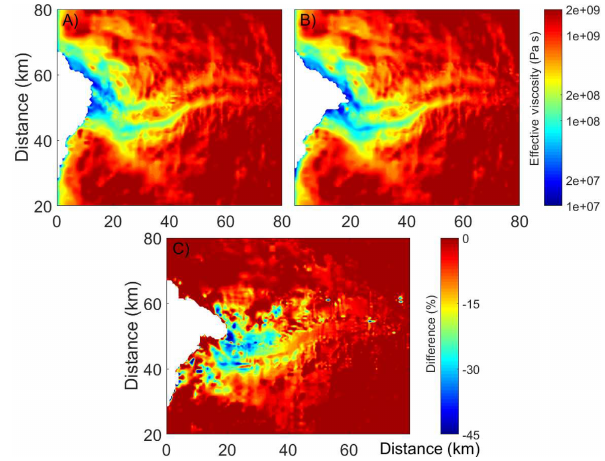
Figure 10. Modeled annual mean of vertically averaged effective viscosity (cid:56) · µ (Eq. 5) in 2004 (a) and 2013 (b) and the percentage decreases from 2004 to 2013 (c)